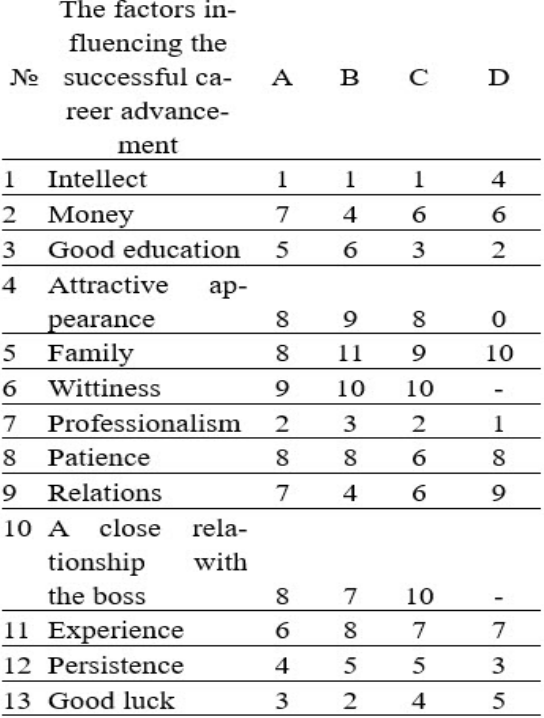
Table 5. The peculiarities of distribution of the factors influencing the successful career advancement in the process of professional